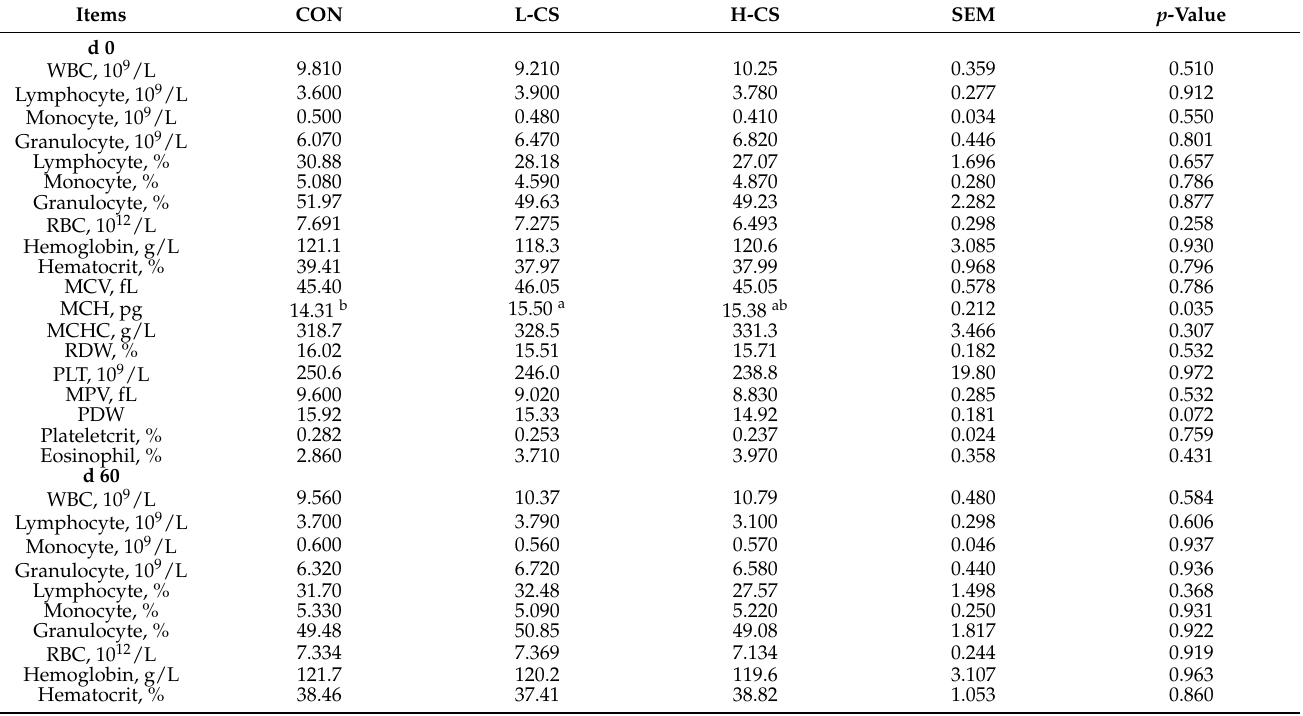
Table 3. Hematological parameters of cats on d 0 and 60 of the